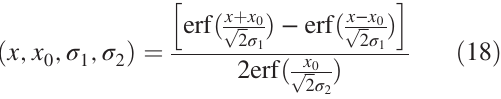
Fig. 16, for a beam energy of 180 eV. To model this, we use a functional form corresponding to the convolution of a Gaussian with rms width σ (proportional to the beam vb vertical width) with a rectangular distribution of half-width θ (proportional to the vertical height of the detector): v